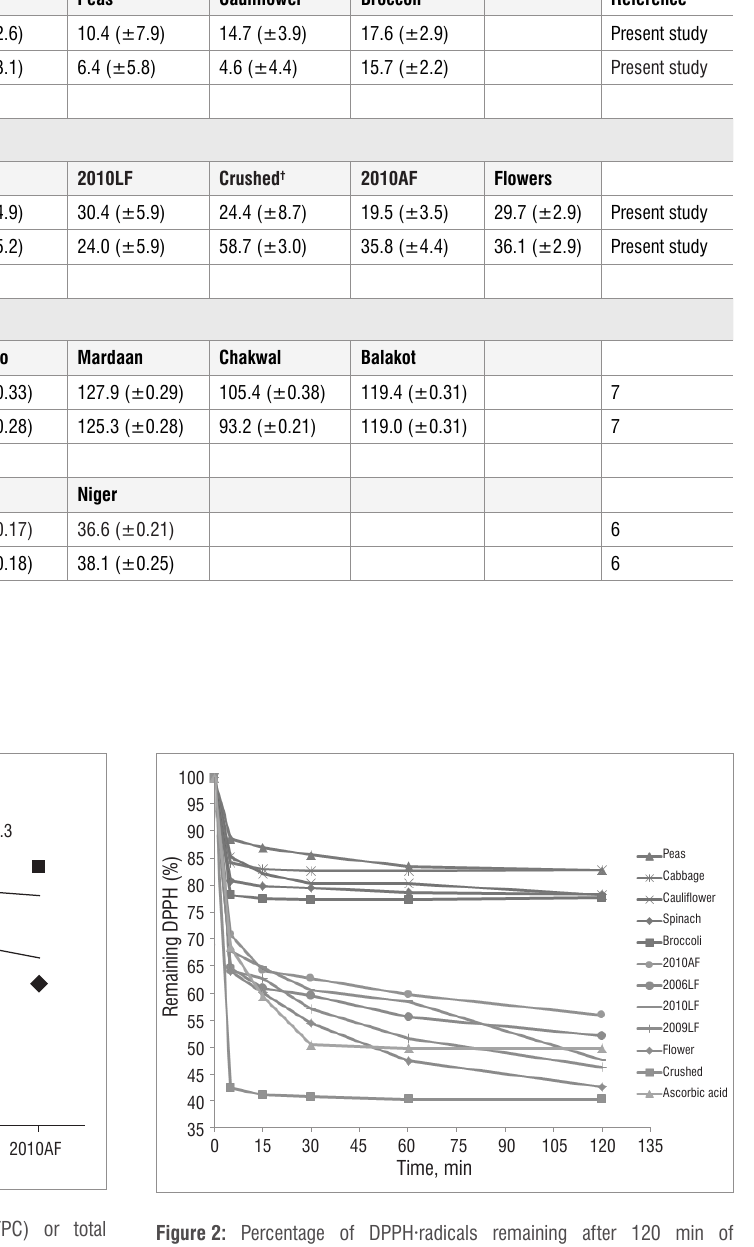
Figure 2: Percentage of DPPH·radicals remaining after 120 min of incubation in undiluted methanol extracts of moringa and vegetable samples ( p <0.05; n=3) and ascorbic acid.